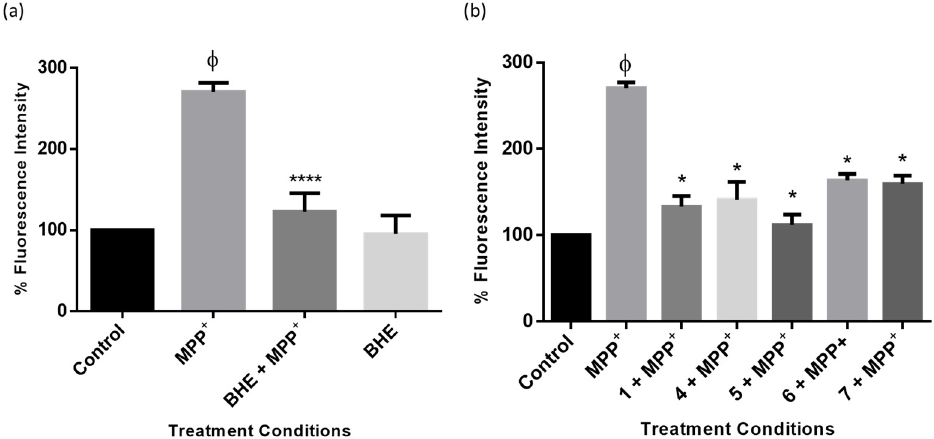
Figure 8. BHE and compounds inhibit MPP + -induced intracellular ROS production. Cells were pre-treated with 2.5 µ g / mL of extracts ( a ) and compounds ( b ) before exposure to 2000 µ M of MPP + for 24 h, and intracellular ROS generation was determined. Each bar represents fluorescence intensity of cells expressed as percentage of control and significance of di ff erence indicated with * ( p < 0.05), and **** ( p < 0.0001) when extract / compounds are compared to MPP + and φ (MPP + vs.